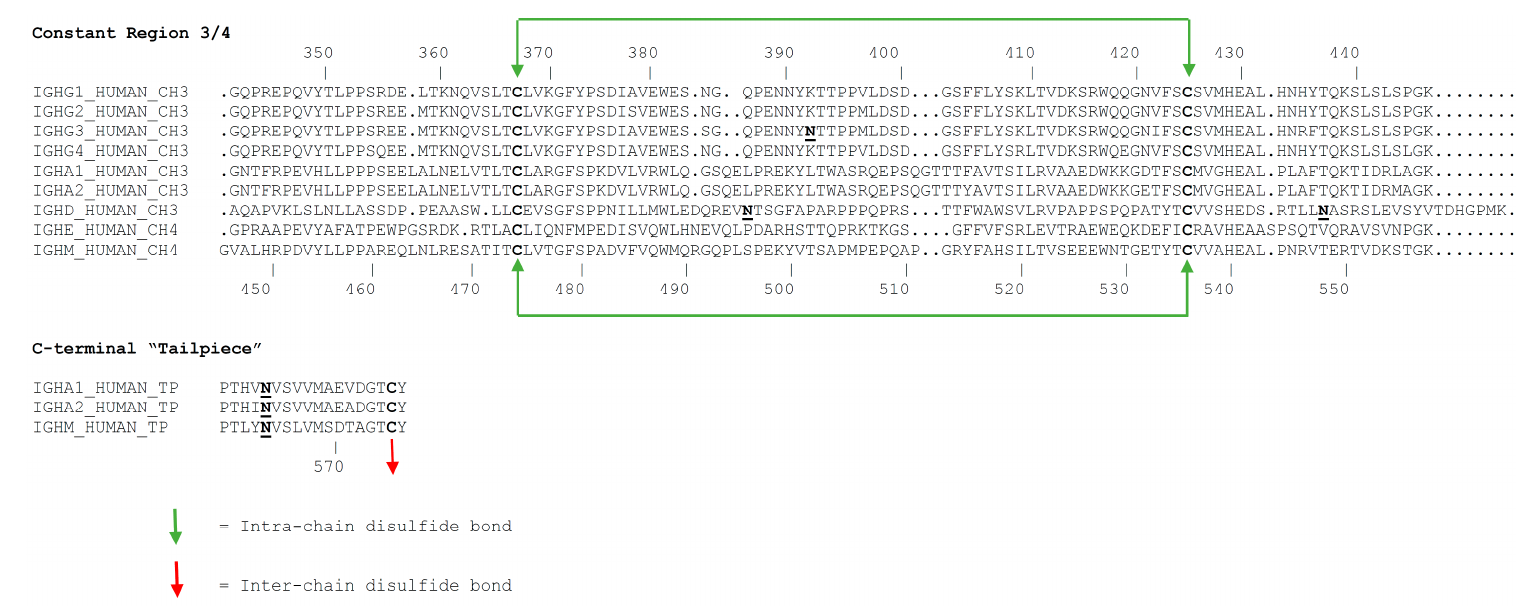
Figure 3. Sequence alignment of the heavy chains of different isotypes of immunoglobulin showing the glycosylation sites and location of inter- and intra-disulfide linkages. The Cµ2 region of IgMs and IgEs is analogous to the hinge regions of the other isotypes. The alignments also highlight, in bold font, the locations of glycosylation sites on each heavy chain. Sequences are numbered according the convention established by Kabat [74].